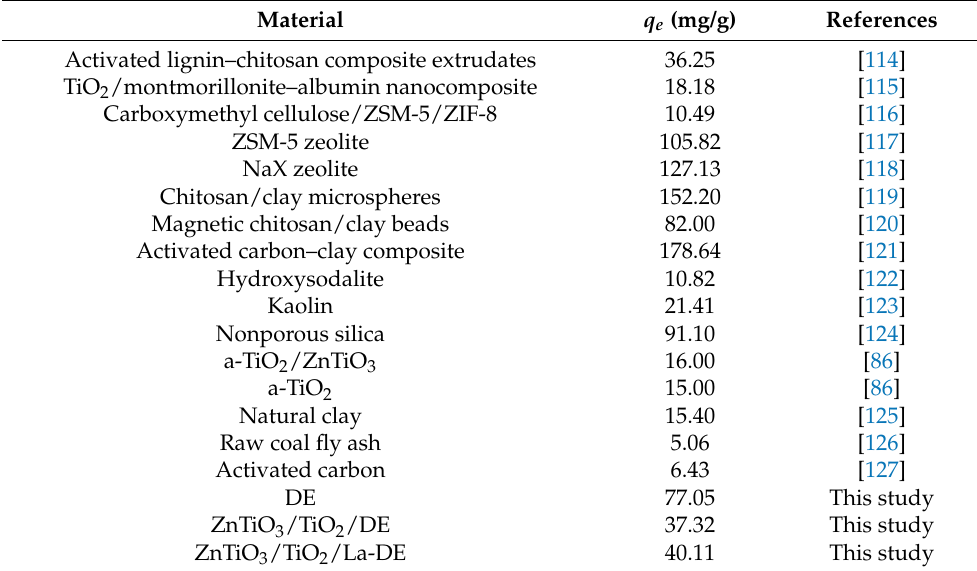
Table 5. MB adsorption capacity of synthesized materials and of other materials reported in the